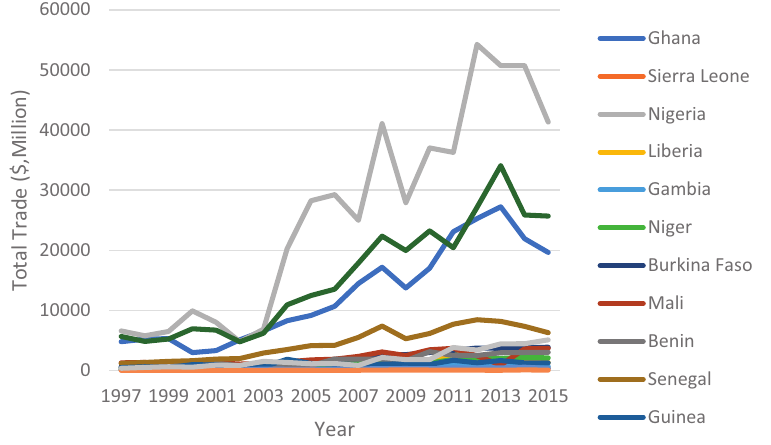
Figure 2. ECOWAS member countries contribution to regional